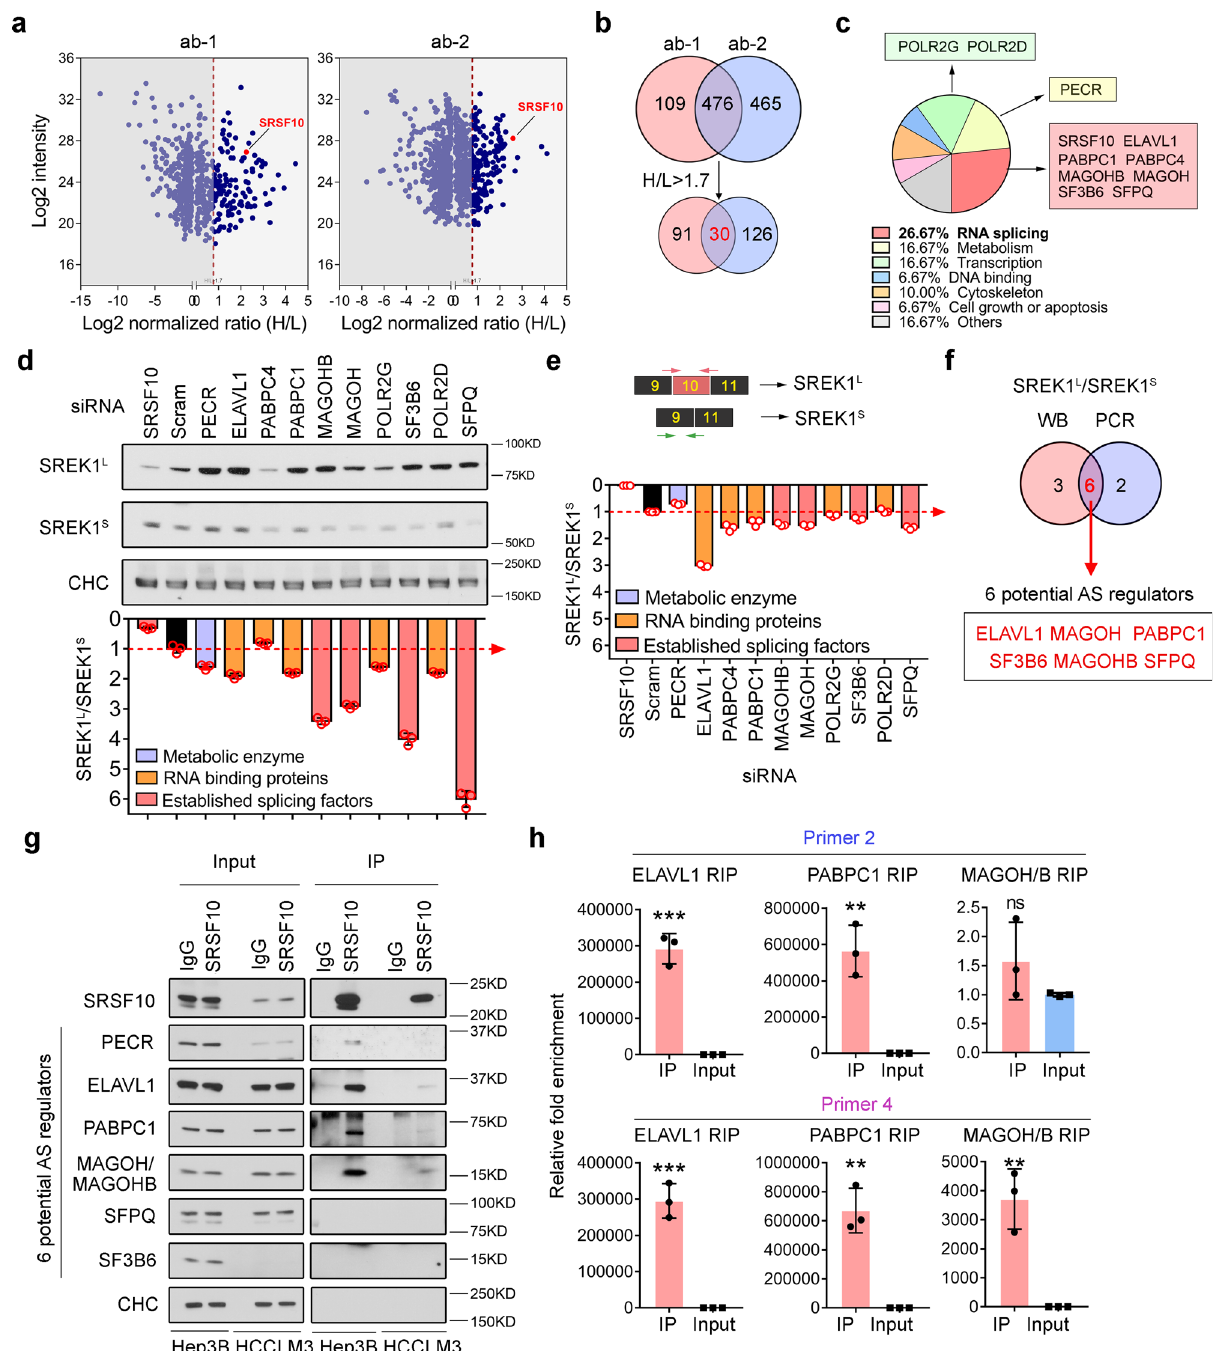
Fig. 7 Dissection of the SRSF10-associated proteins involved in regulating SREK1 L in HCC cells. a Dot plots of endogenous SRSF10 interactors identi fi ed by the SILAC approach using two commercial antibodies against SRSF10 in Hep3B cells. The SRSF10 bait protein was indicated by red dots, and the dashed line indicates the cut-off of H/L ratio. b Venn diagram analysis identi fi ed 30 SRSF10 potential interactors identi fi ed by both antibodies with the cut-off of H/ L > 1.7. c Functional annotation of the 30 interactors indicating that 26.67% are related to RNA splicing, and the interactors identi fi ed in the top 3 pathways are labeled in colored boxes. d Immunoblot analysis of SREK1 L , SREK1 S and Clathrin heavy chain (CHC) following the knockdown of each of the identi fi ed SRSF10 interactors in Hep3B cells. The ratios of SREK1 L /SREK1 S were quanti fi ed, and the ratio in cells with a scramble control was set as the cut-off indicated with a dotted red line ( n = 3). e Ratio of SREK1 L /SREK1 S mRNA expression post the knockdown of each SRSF10 interactors, and expression in cells with a scramble control was set as the cut-off indicated with a dotted red line ( n = 3). f Venn diagram analysis identi fi ed six common SRSF10 splicing- related interactors determined by both immunoblotting and real-time PCR. g Independent endogenous immunoprecipitation validation of the six SRSF10 splicing-related interactors in Hep3B and HCCLM3 cells. h RIP analysis demonstrated that three of the validated SRSF10 interactors binding with SREK1 L mRNA in Hep3B cells ( n = 3). Mean ± SD, two-tailed, unpaired t test is used for ( d , e , h ), ** p < 0.01; *** p < 0.001. Source data are provided as a Source Data fi